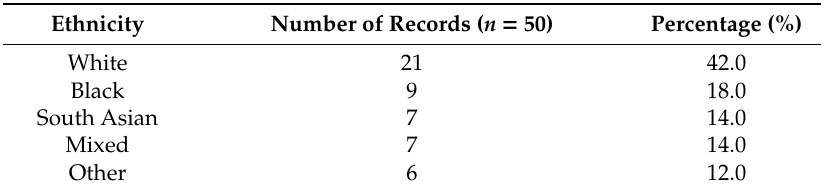
Table 2. Distribution according to